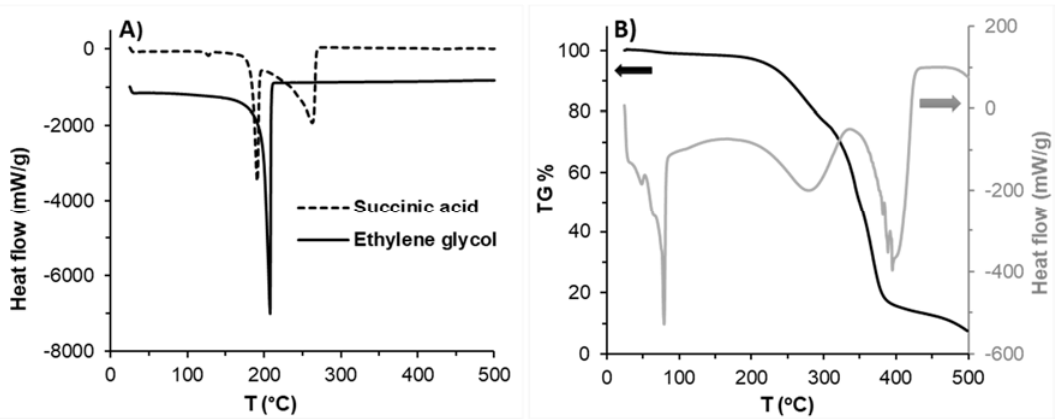
Figure 2. ( A ) DSC curves of the initial monomers (ethylene glycol and succinic acid), ( B ) DSC- and TG-curve of PES polyester (80 min polycondensation time).